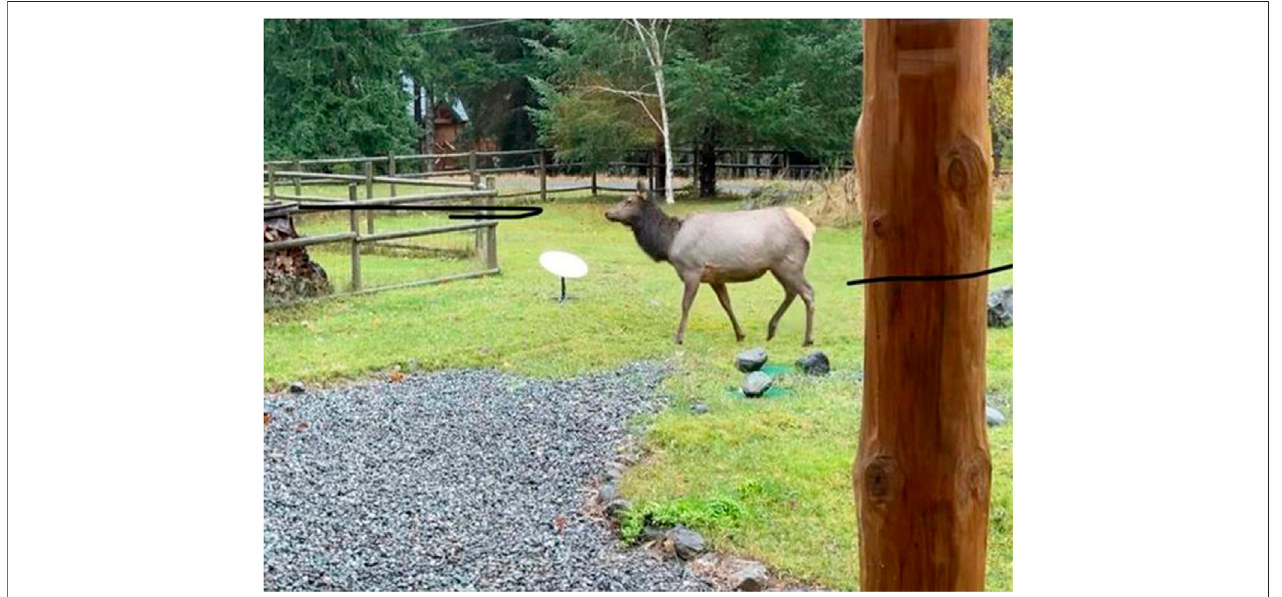
FIGURE 1 | Dish with clear view of the sky and friendly elk (Reddit,